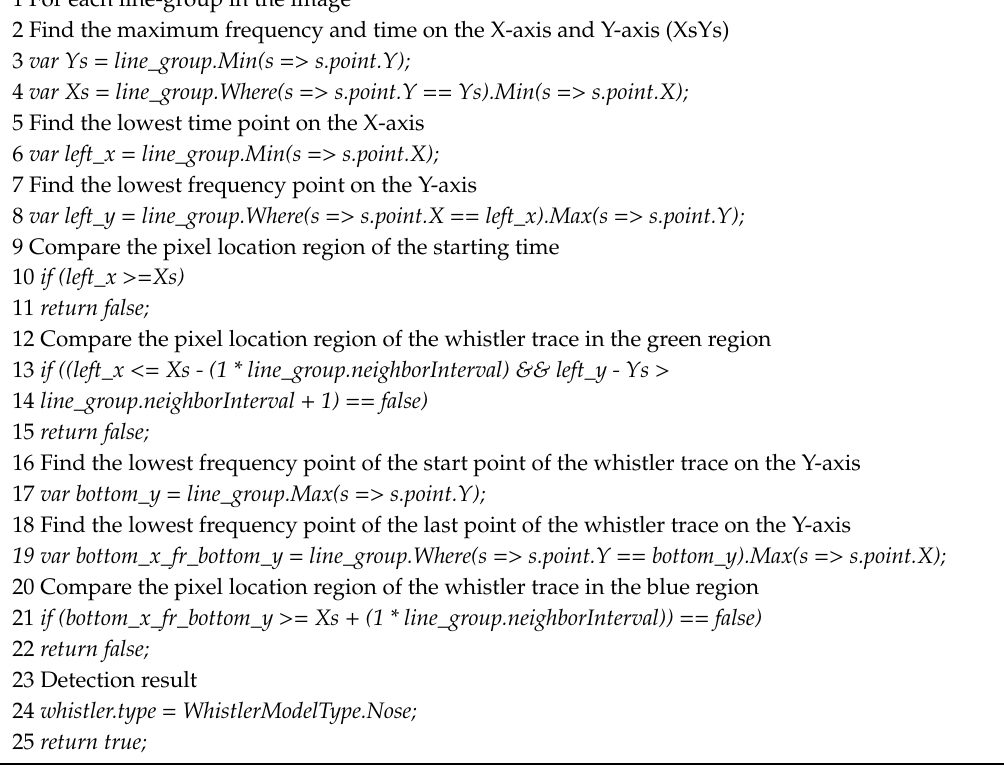
Algorithm 1 The Nose-whistler detection Algorithm 1: The Nose-whistler detection algorithm 335